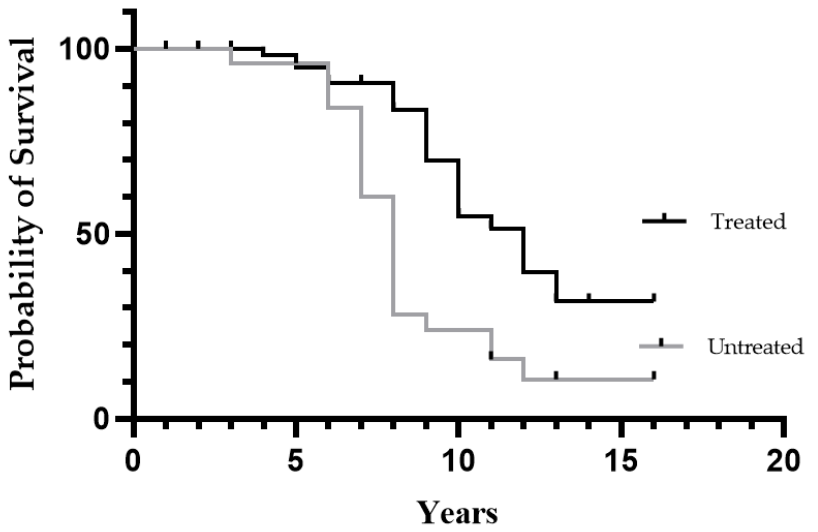
Figure 2. Survival comparing patients who received disease-modifying treatment ( n = 71) vs. un- treated patients ( n = 34).